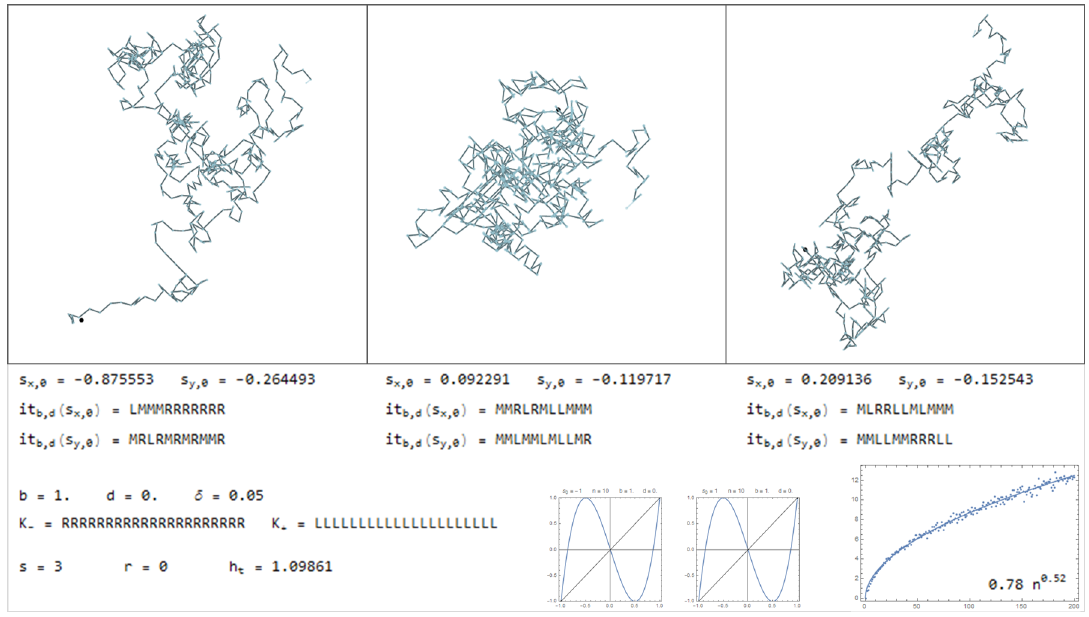
Figure 11. Trajectories produced with b = 1 and d =